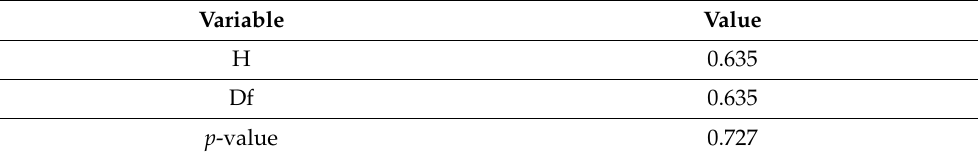
Table 4. Result for usability evaluation—Kruskal–Wallis Test. Variable